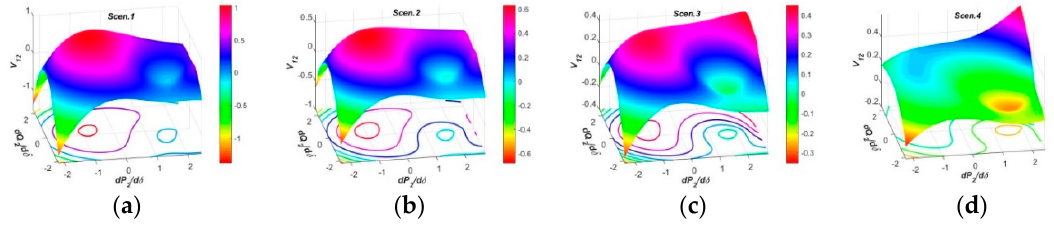
Figure 10. Spatial surfaces of PFG to CIV2 at SCP2 in spaces: ( a – d ) Spatial surfaces of PFG to CIV2 in four regulation scenarios.